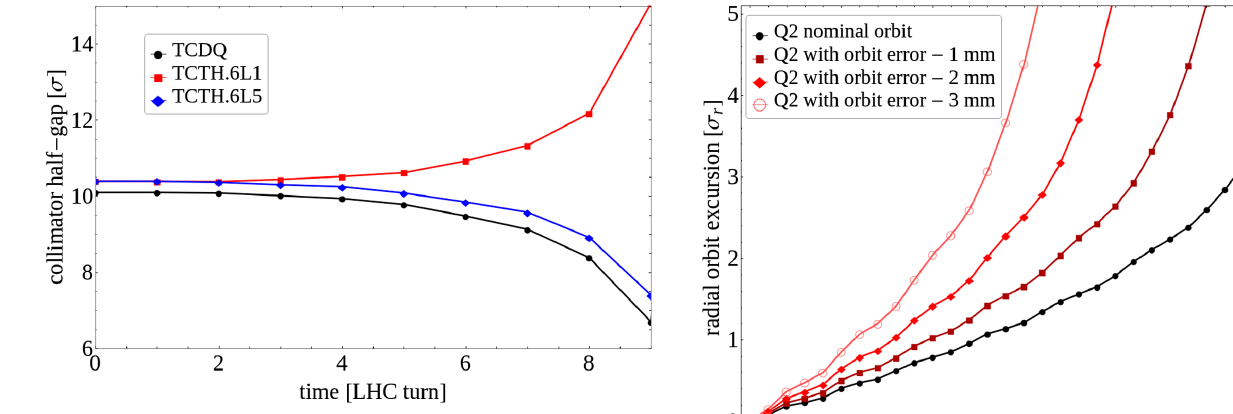
FIG. 14. The effective collimator gap settings of the dump absorber (TCDQ) and the horizontal tertiary collimators (TCTH) in IPs 1 and 5 following a CLIQ discharge in the Q2 magnet right of IP1, constituting the fastest case — flat optics. FIG. 15. Comparison of different orbit errors and their effect on the orbit excursion resulting from a CLIQ discharge in the worst magnet. Only round optics is considered, and the orbit errors are applied both horizontally and vertically